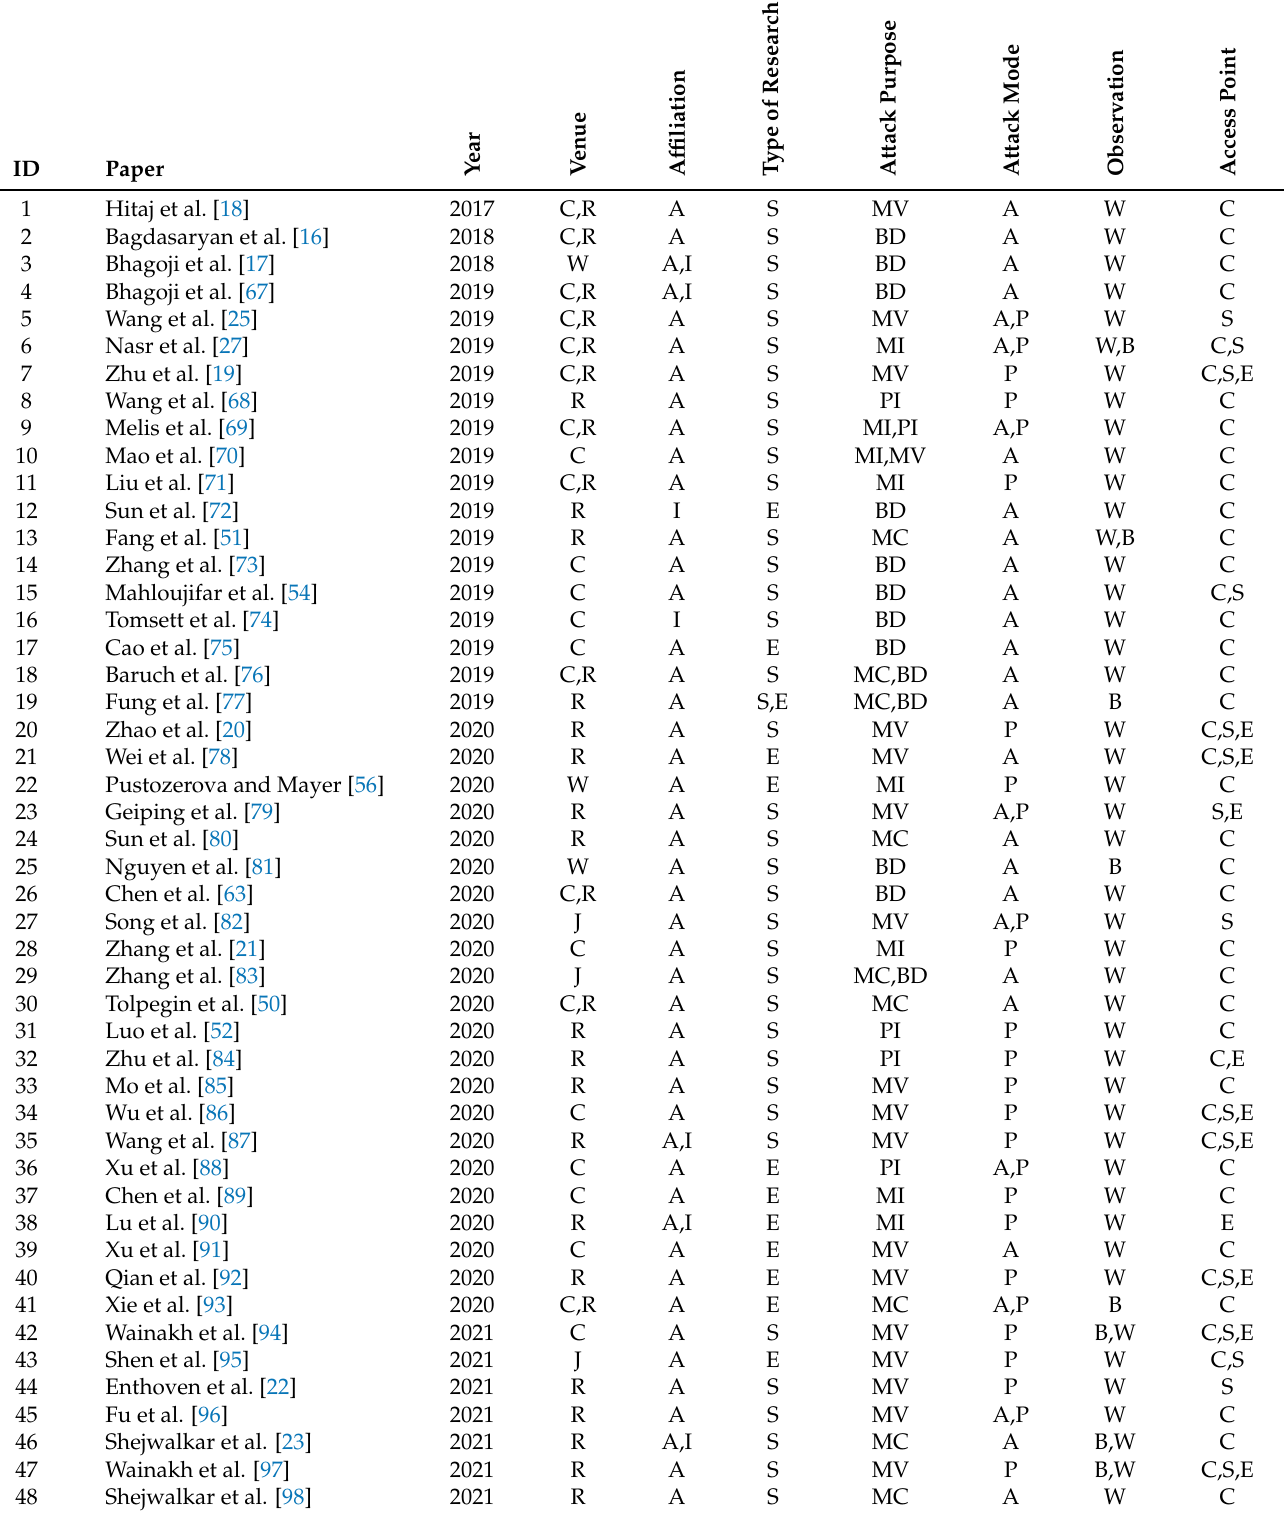
Table 3. Mapping results for the studied papers with regard to meta data and attacks